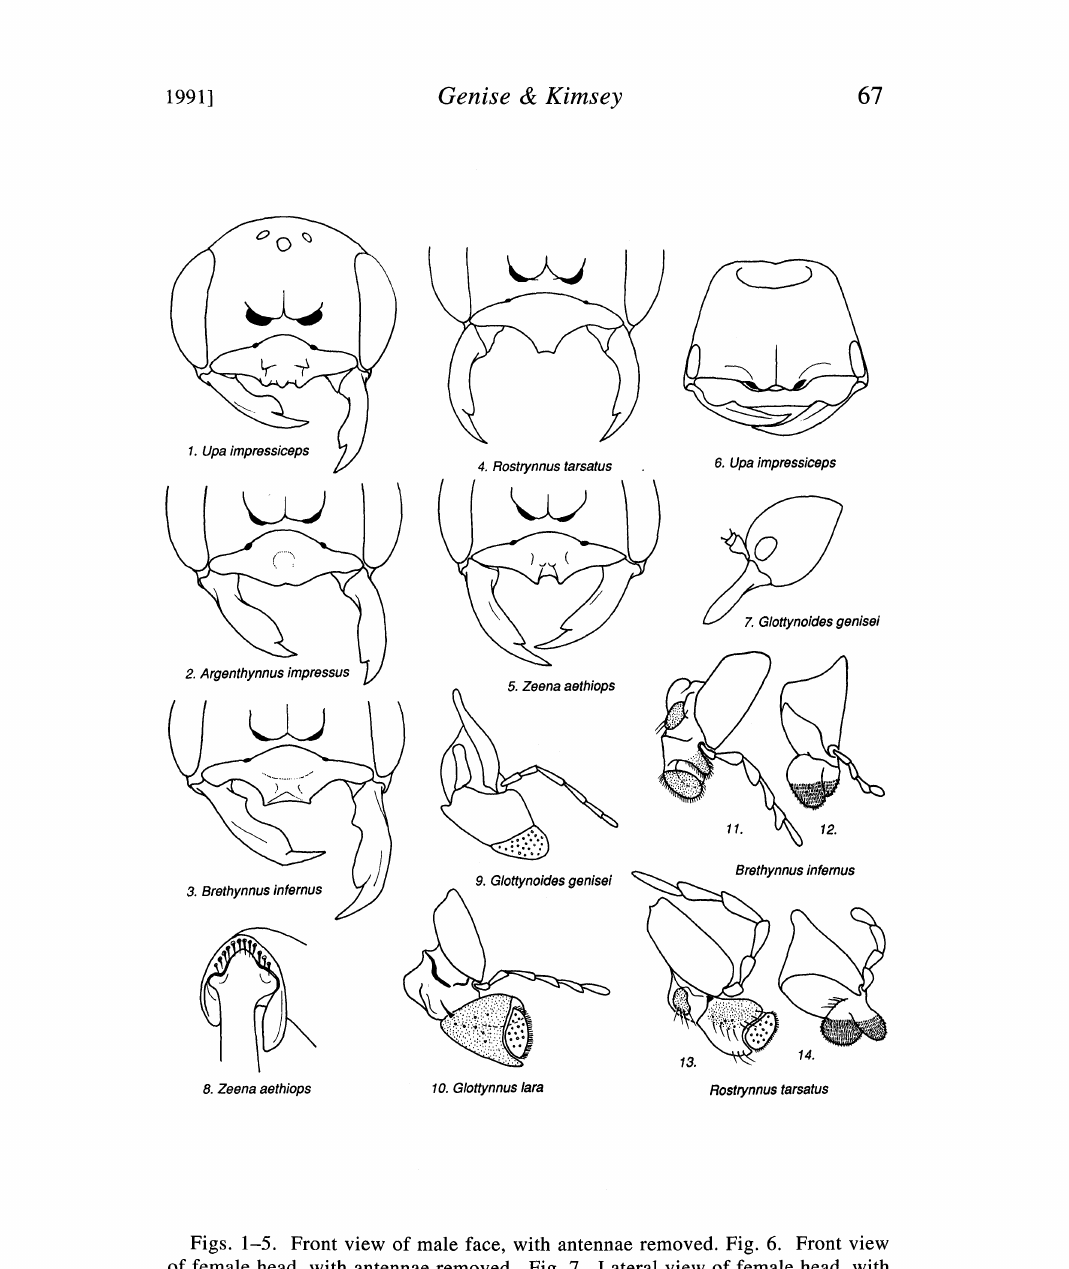
Figs. 1-5. Front view of male face, with antennae removed. Fig. 6. Front view of female head, with antennae removed. Fig. 7. Lateral view of female head, with flagellum removed. Fig. 8. Femorotibial joint of male hindleg. Figs. 9, 10, 12, 13. Male maxilla. Figs. 11, 14. Male